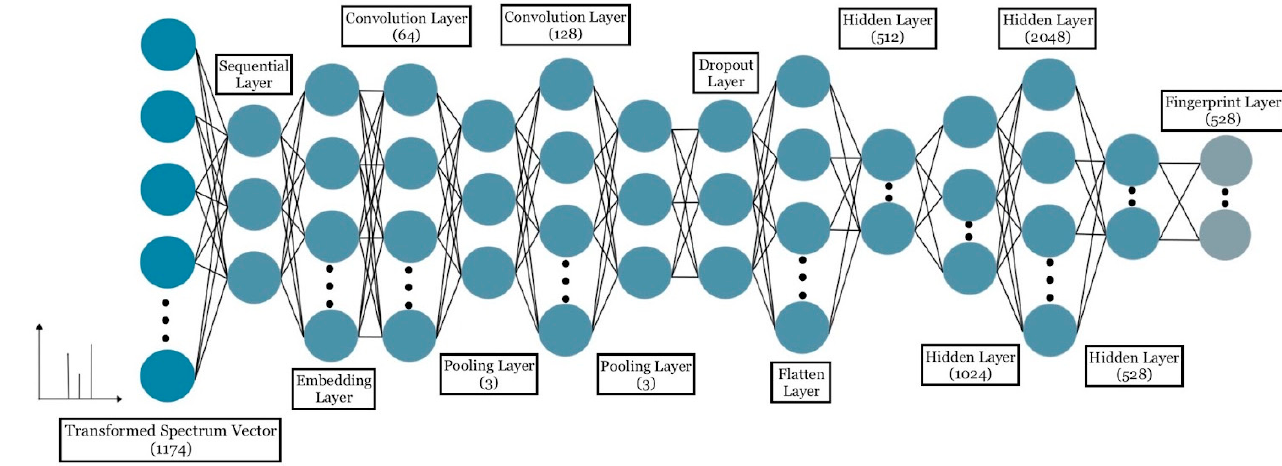
Figure 2. Architecture of CNN.